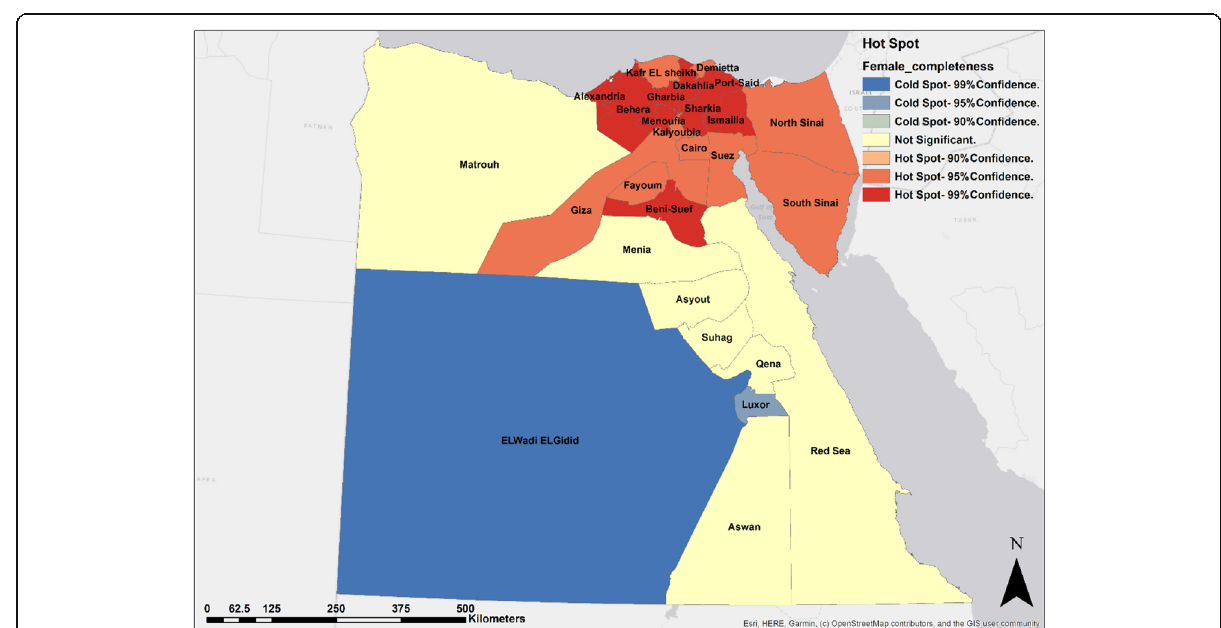
Fig. 4 Hot spots of the completeness of female death registration, Egypt, 2017